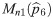
A. Neurotransmitter feed-forward model Mn1(p^6) fitted to data. The figure shows mean values and standard error (SE) from primary stimulus in the intensity experiment. B. Interaction graph of the minimized model Mn2. Vasodilating (grey) states contribute positively to the output term and vasoconstricting (hatched) states contribute negatively. S1 … S6 are different states in the model. The behavior of these states are represented with the same color coding in C. C. (upper panel) Main mechanism of Mn2. The solid grey line shows the action of the vasodilating terms and the black hatched line shows the behavior of the vasoconstricting terms. The insets show the small, but essential, differences that give rise to the initial dip and the post-peak undershoot. C. (lower panel) Resulting BOLD response from Mn2. The vasodilating states minus the vasoconstricting states give rise to a BOLD response with initial dip, peak, and post-peak undershoot.